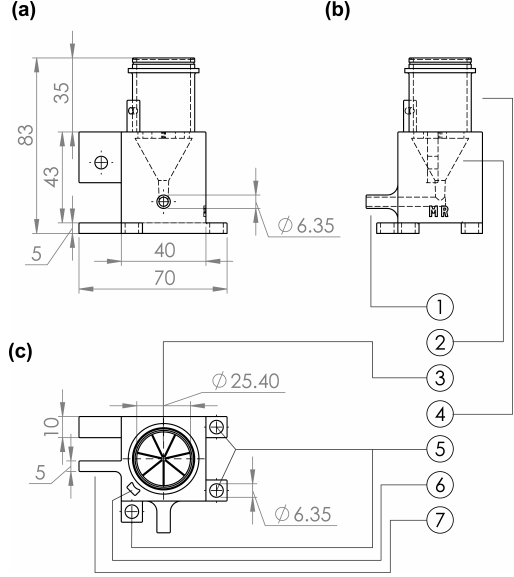
Figure 1. Dimensioned drawings of PRIZE: (a) rear view; (b) side view; (c) top view. All dimensions are in millimeters. The genera- tor body consists of seven components: (1) inlet, (2) internal cone, (3) radial grid with openings, (4) elutriator tube, (5) mounting holes, (6) LED mount and (7) rotameter (or other flow meter) mount.